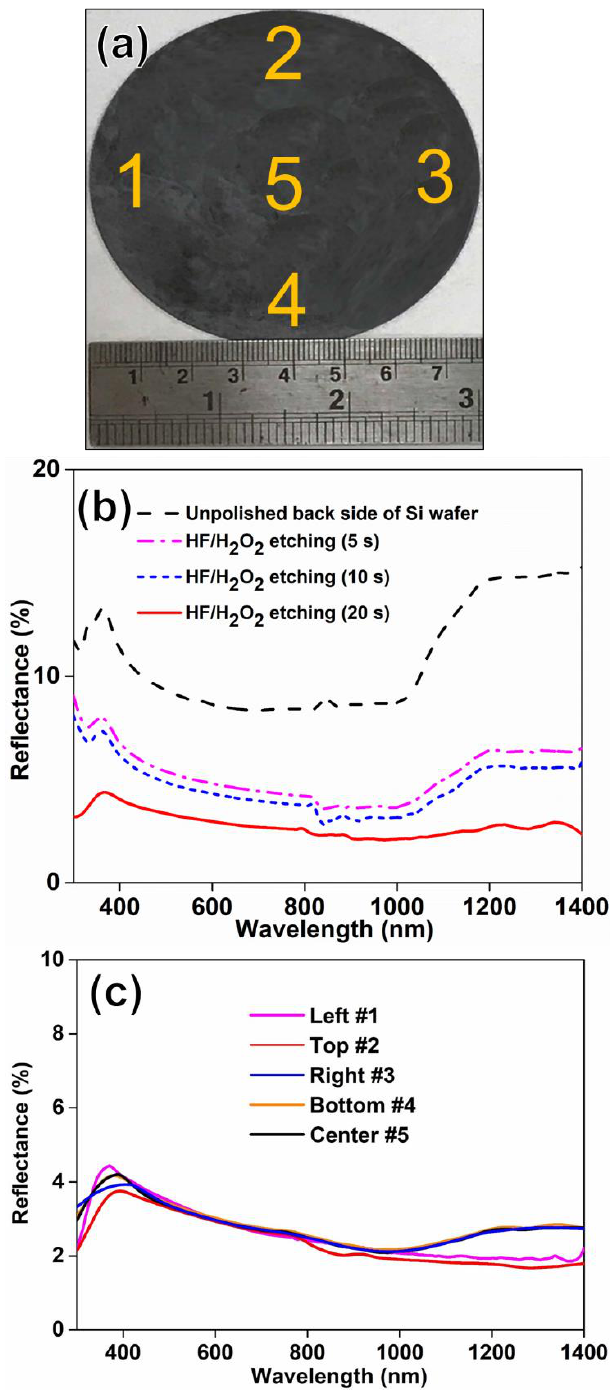
Figure 5. ( a ) Digital photograph of 5 s etched Si wafer (unpolished side) after removal of Ag nanoparticles. ( b ) Diffused reflectance spectrum of the unpolished side of Si wafer etched for different time intervals varying from 0 s to 20 s. ( c ) Reflectance spectra from five different regions of the 5 s etched Si wafer. Note: Reflectance spectrum shown is a mean of reflectance measured from five different regions of the wafer marked as #1 (left), #2 (top), #3 (right), #4 (bottom) and #5 (central area).